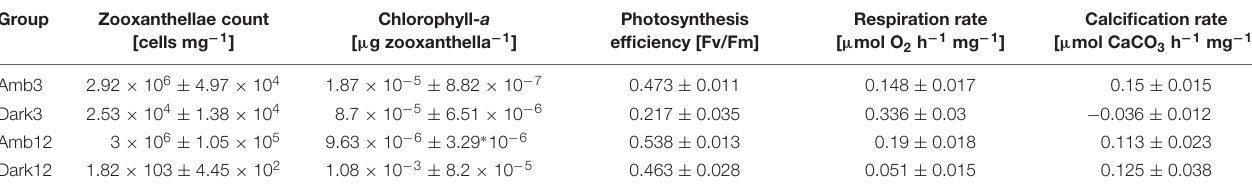
TABLE 2 | Values of zooxanthellae cell count, chl- a concentration, photosynthesis efficiency, hourly respiration rate and hourly calcification rate per protein ( ± SE) in the different study time points and environments ( n = 3 per time point and environment).